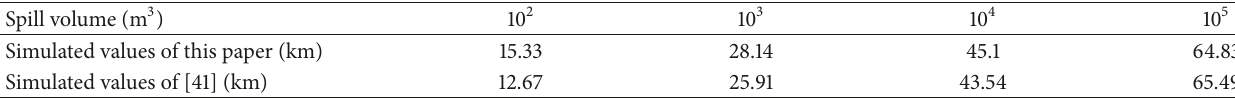
Figure 7: Comparison of the flume experiment (a, c) and the simulated result (b) of the spreading and drift of the oil slick. Table 1: Comparison of the major axes scales of the oil slick.